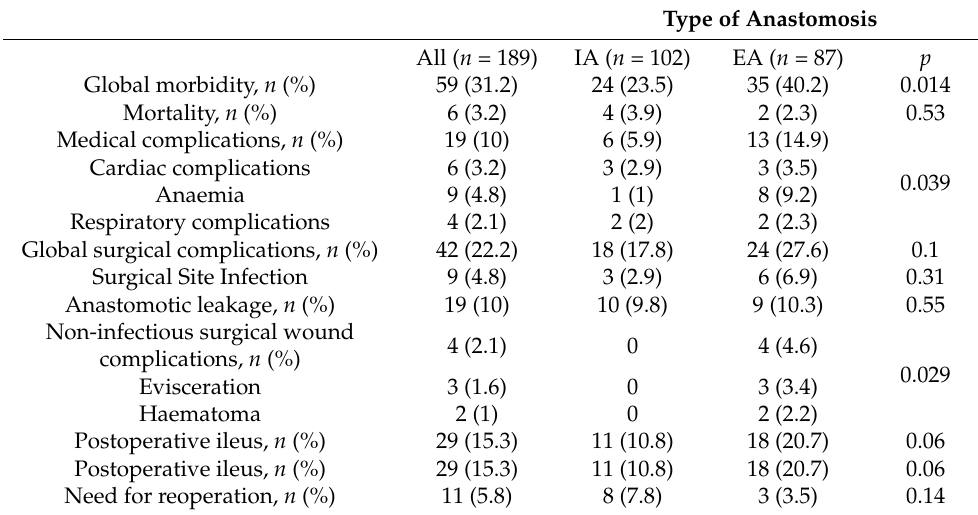
Table 2. Morbimortality according to anastomotic